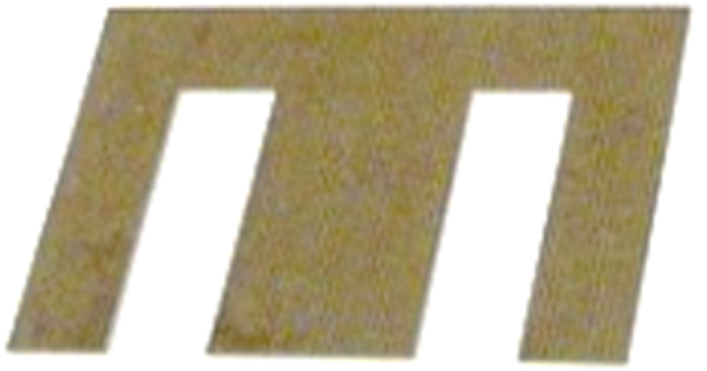
Figure 20. Transformer core sheet cut with optimal technological parameters from grain-oriented electrical steel.